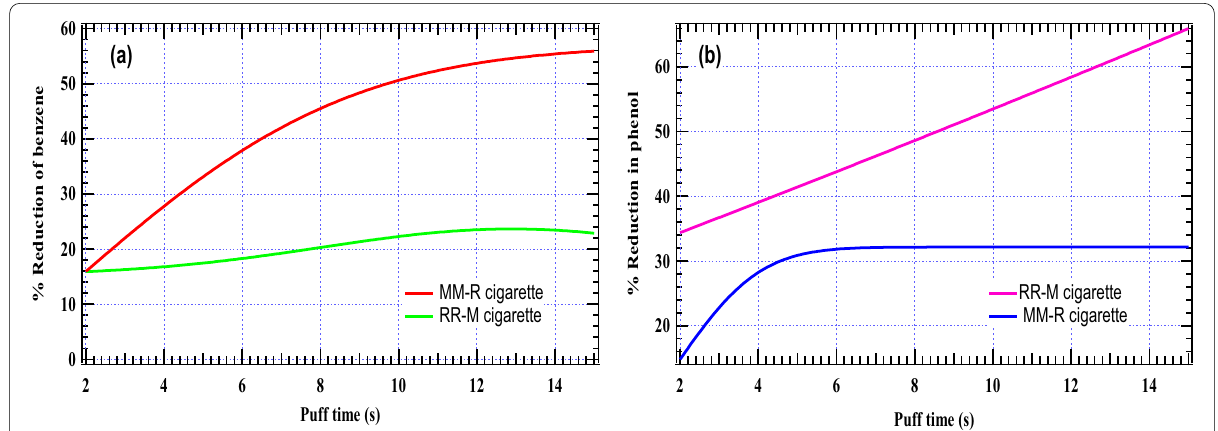
Fig. 7 Comparative destruction of benzene ( a ) and b destruction of phenol in MM-R and RR-M model cigarettes as a function puff